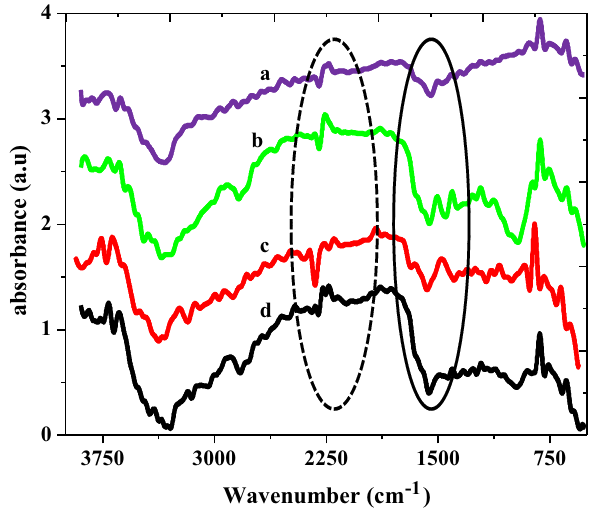
Fig. 4 FTIR spectra of (a) SH, (b) MSH and (c) MSH after adsorp- tion of MB and (d) after adsorption of